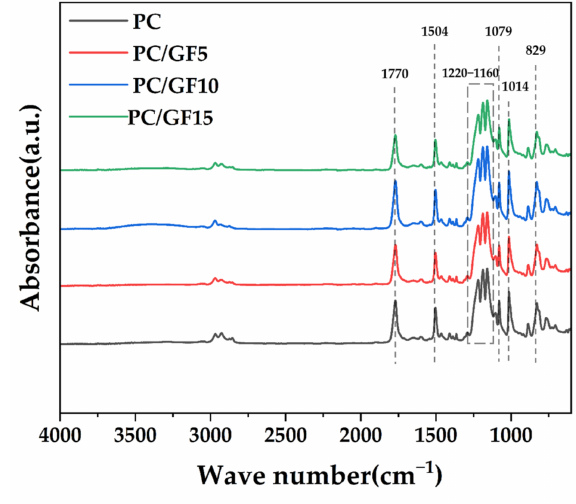
Figure 1. FTIR diagrams of PC/GF composites and PC.